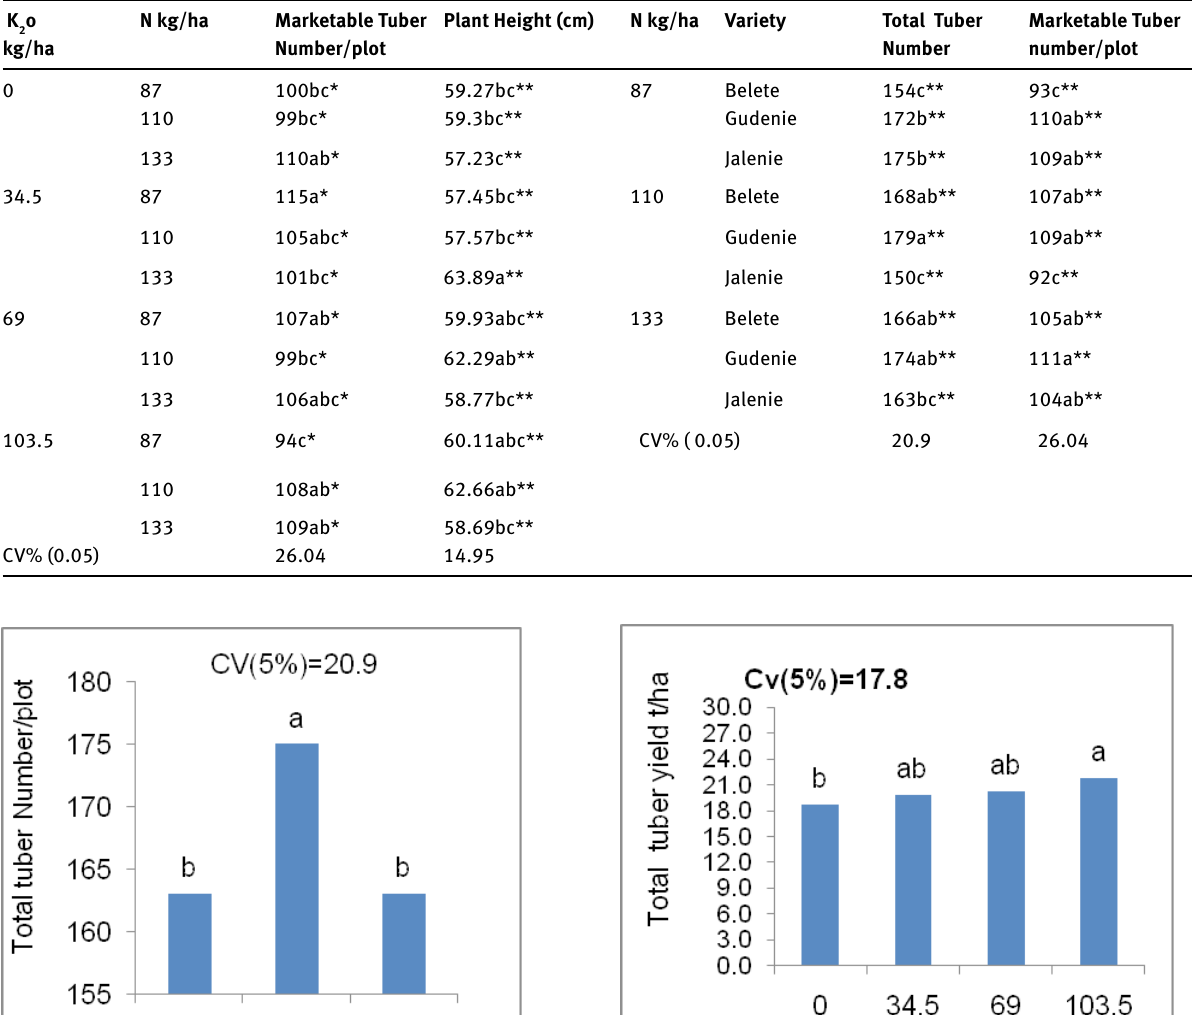
Table 2: Interaction of nitrogen with potassium and variety effect on tuber number and plant height K o 2 kg/ha